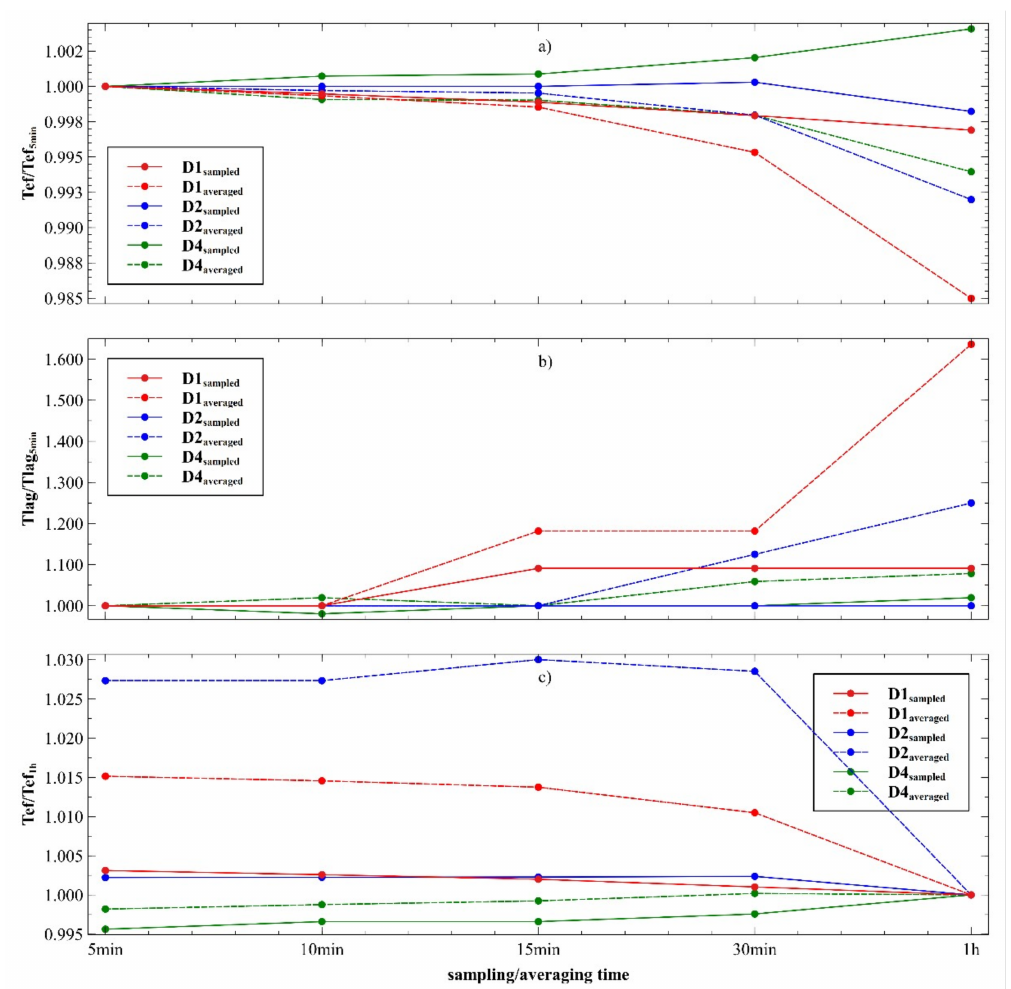
Figure 10. ( a ) Tidal e ffi ciency convergence test result based on the observation datasets made from 30 April to 4 May 2019 for fixed sea level sampling time equal to 5 min; ( b ) time lag convergence test result based on the observation data sets made from 30 April to 4 May 2019 for fixed sea level sampling time equal to 5 min; ( c ) tidal e ffi ciency convergence test result based on the observation datasets made from 30 April to 4 May 2019 for fixed sea level sampling time equal to 60